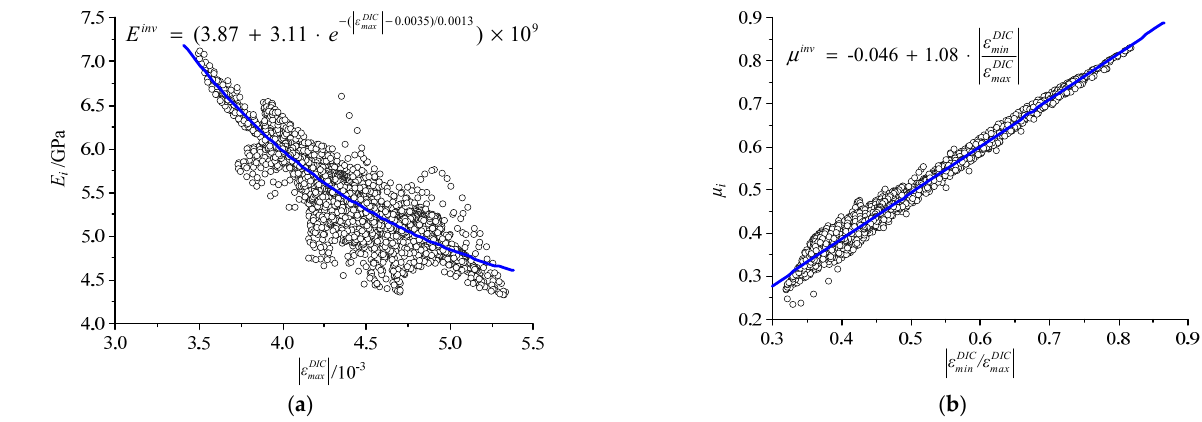
Figure 10. Evolution curves of ( a ) micro Young’s modulus and ( b ) Poisson ratio.